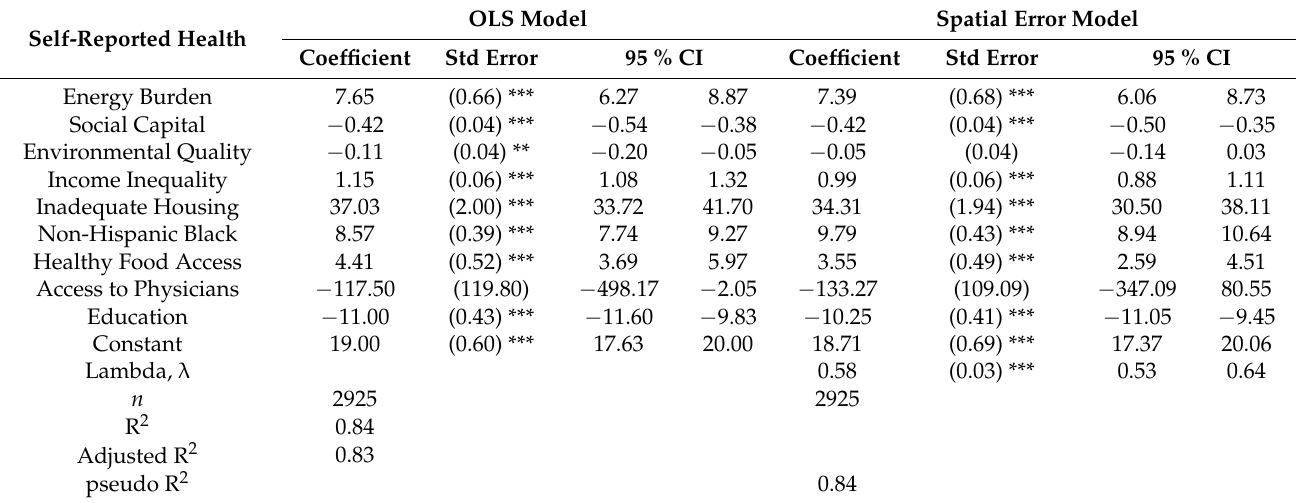
Table 3. The results of spatial error models of factors shaping self-reported health in US